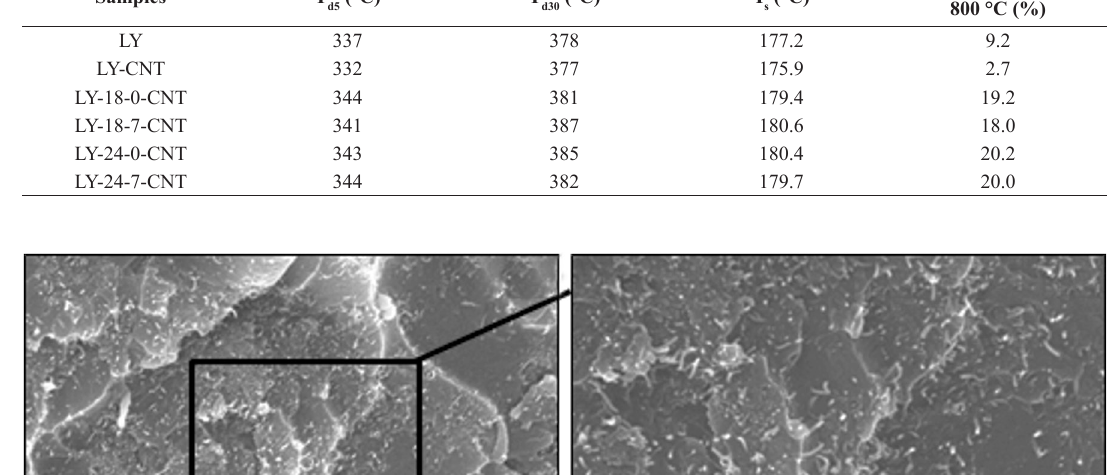
Table 3. Thermal stability parameters obtained from TGA of the hybrid nanocomposites. Samples